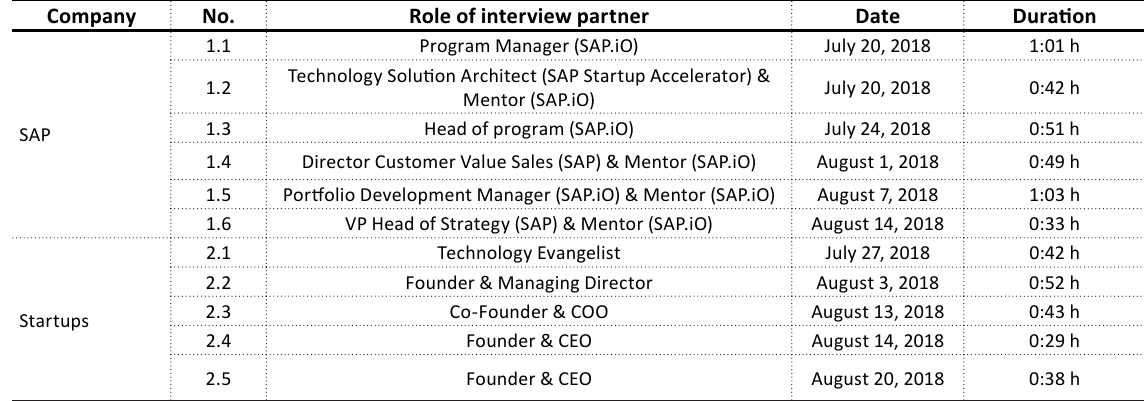
Table 3. O verview of